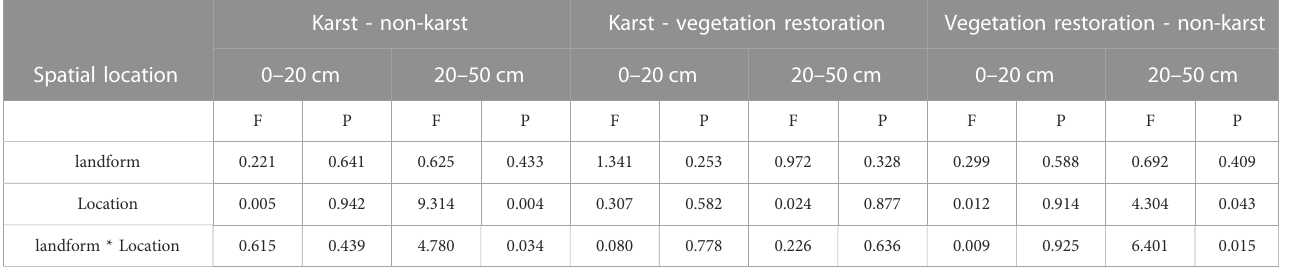
TABLE 6 Generalized linear mixed model (GLMM) analysis of soil DOC. Karst -